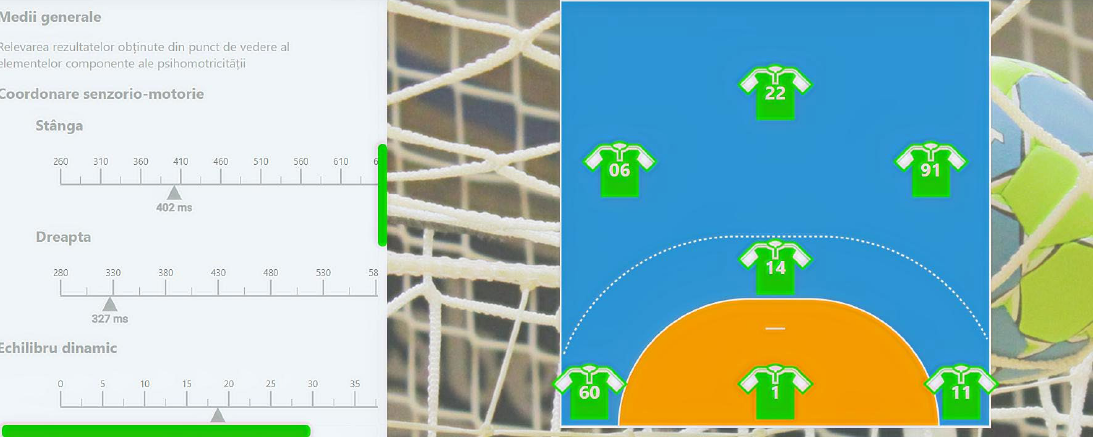
Figure 1. Representation of the created software’s first page.